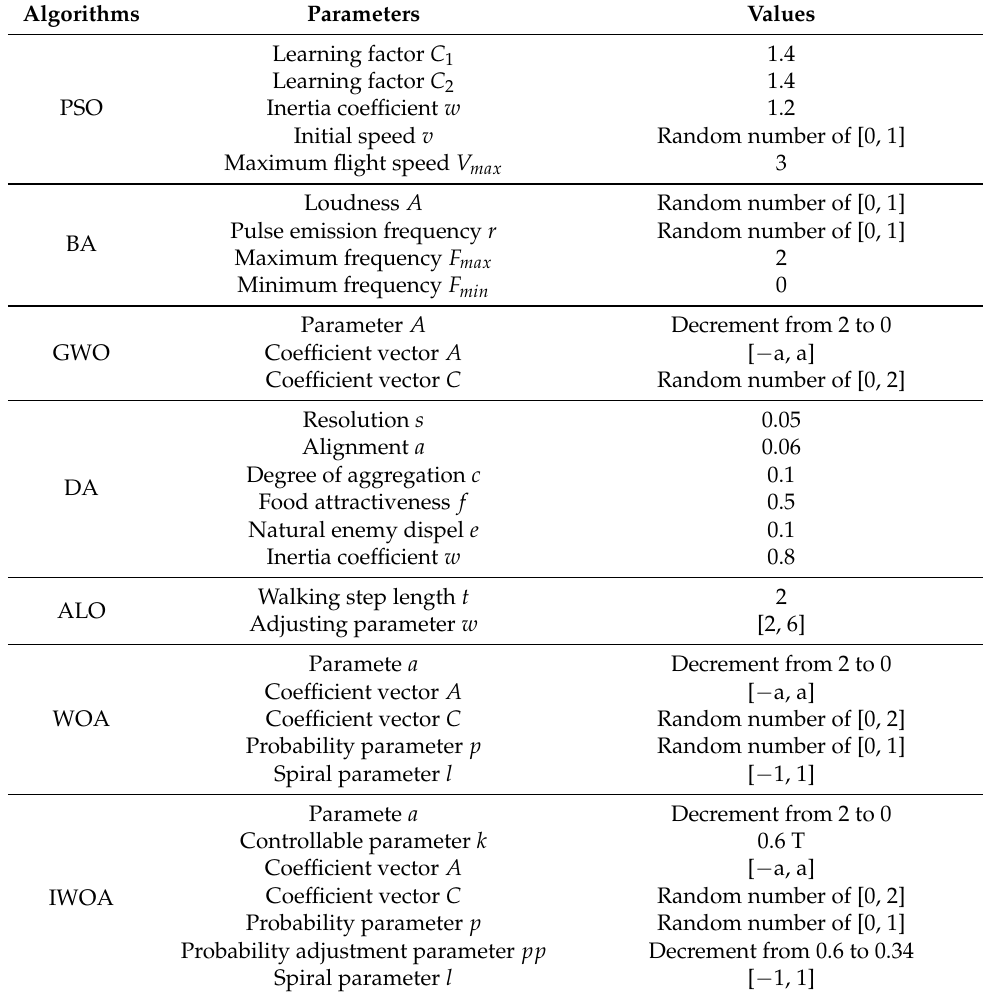
Table 2. Comparison table of algorithm